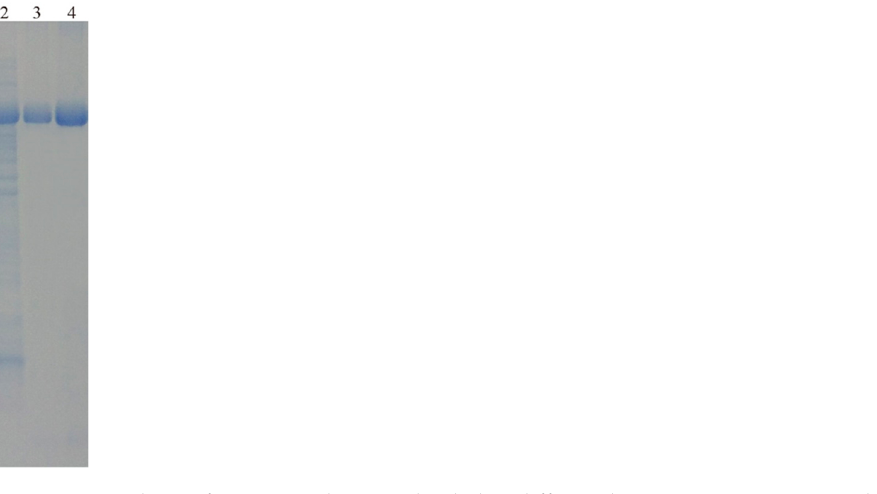
Figure 3. SDS-PAGE analysis of L01. Samples were loaded in different lanes. Lane M, prestained protein ladder; Lanes 1–2, the concentrated fermentation broth; Lanes 3–4, purified L01.